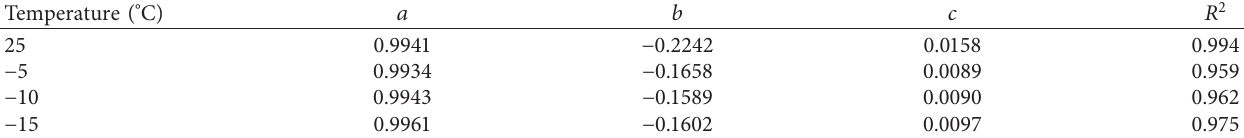
Table 4: Fitting coefficients for the strength attenuation coefficient at different temperatures.